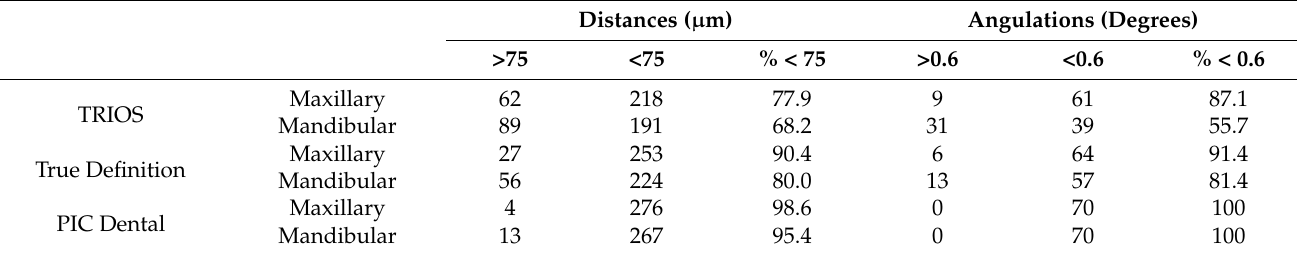
and 95.4% for PIC, 90.4% and 80.0% for TD, and 77.9% and 68.2% for T. The percentage of angulations below the arbitrary limit of 0.6 degrees were; 100% and 100% for PIC, 91.4% and 81.4% for TD, and 87.1% and 55.7% for T (Table 3). Table 3. Descriptive statistics where number of distances and angulations that were above/below the previously established limits are shown.